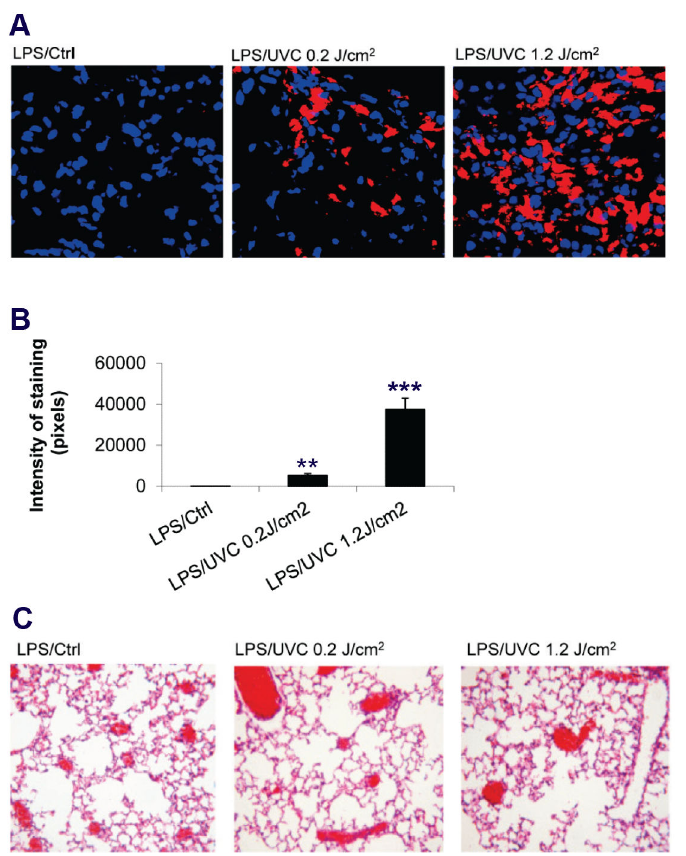
Figure 4. In vivo lung accumulation of UVC-irradiated HPs in the 2-event SCID mouse model. A ) Mice were pretreated with an intraperitoneal injection of 3 mg/kg LPS 2 hours before intravenous infusion of untreated control or UVC-irradiated HPs at low (0.2 J/cm 2 ) and high (1.2 J/cm 2 ) doses, respectively. Shown are anti-human CD41 immunohistochemistry staining of lung frozen sections; B ) Quantification of pixel intensity of anti-hCD41 staining of images shown in A. Mean ± SE, n=3; C ) Lung histology from H&E staining of lung paraffin sections. Shown is a representative of three independent experiments. doi: injury and release of macrophage inflammatory protein 2